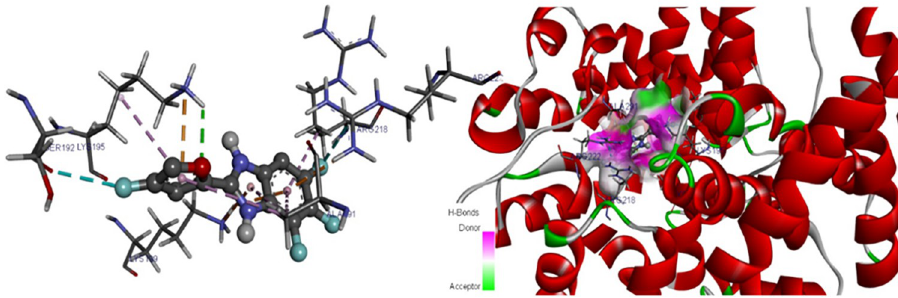
Fig 10. 3D depictions of docking of 5g in the active site of human serum albumin .